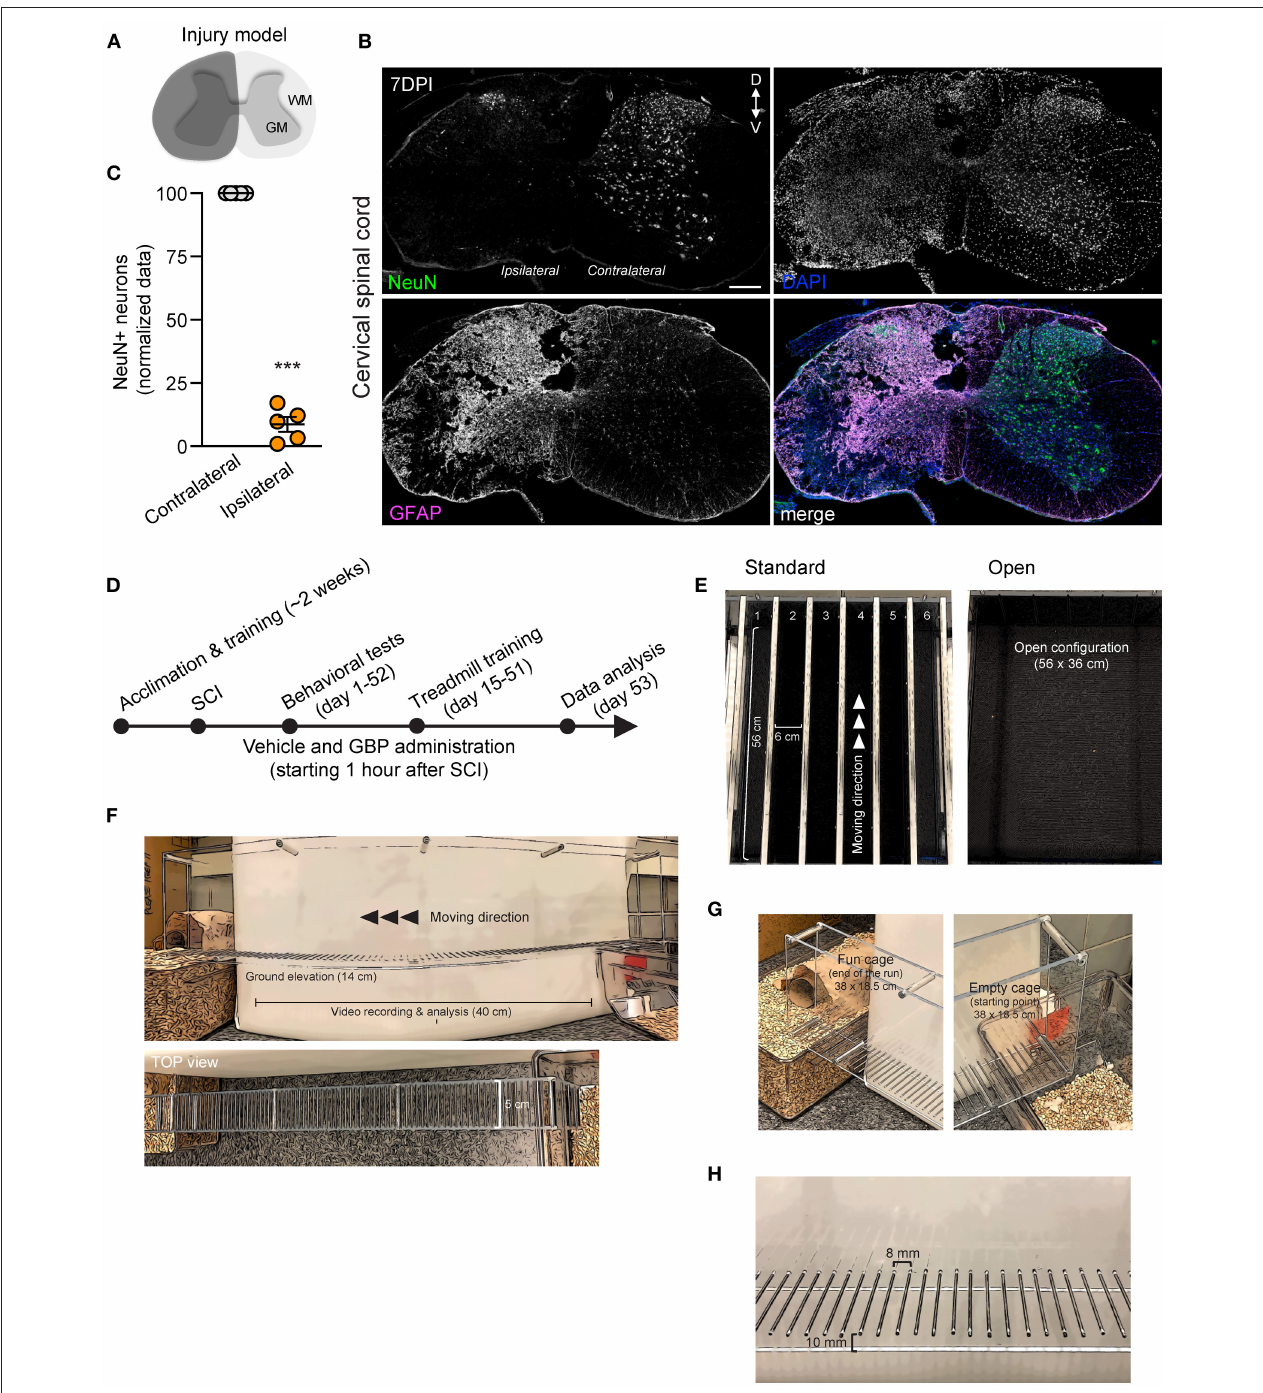
FIGURE 1 | An experimental model of cervical SCI in adult mice and behavioral devices. (A) Schematic representation of C5 SCI experimental model. The region in dark gray represents the lesion site. (B) Coronal section of the injured spinal cord stained using GFAP and NeuN antibodies (DPI, days post-injury; D, dorsal; V, ventral). DAPI stained nuclei. Scale bar, 200 µ m. (C) Quantification of (B) . Mean and SEM (paired 2-tailed Student’s t -test *** p < 0.001, n = 5 biological replicates). (D) Experimental scheme. (E) Representative photographs of the treadmill apparatus in a standard and open (group runs) configuration. (F–H) Representative photographs of the skilled walking device. Mice were trained to cross the ladder from right (empty cage) to left (fun cage).